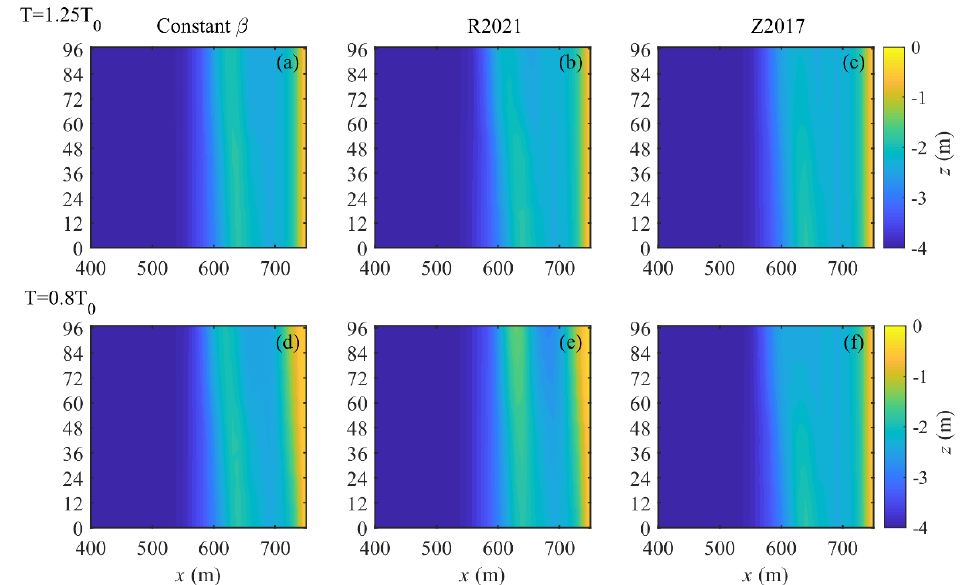
Figure 9. Spatial–temporal evolution of the sandbar predicted by constant roller slope ( a , d ) and the roller slope of R2021 ( b , e ) and Z2017 ( c , f ) under two different wave periods. Figure 9a–c are calculated with T = 1.25 T 0 , and Figure 9d–f are calculated with T = 0.8 T 0